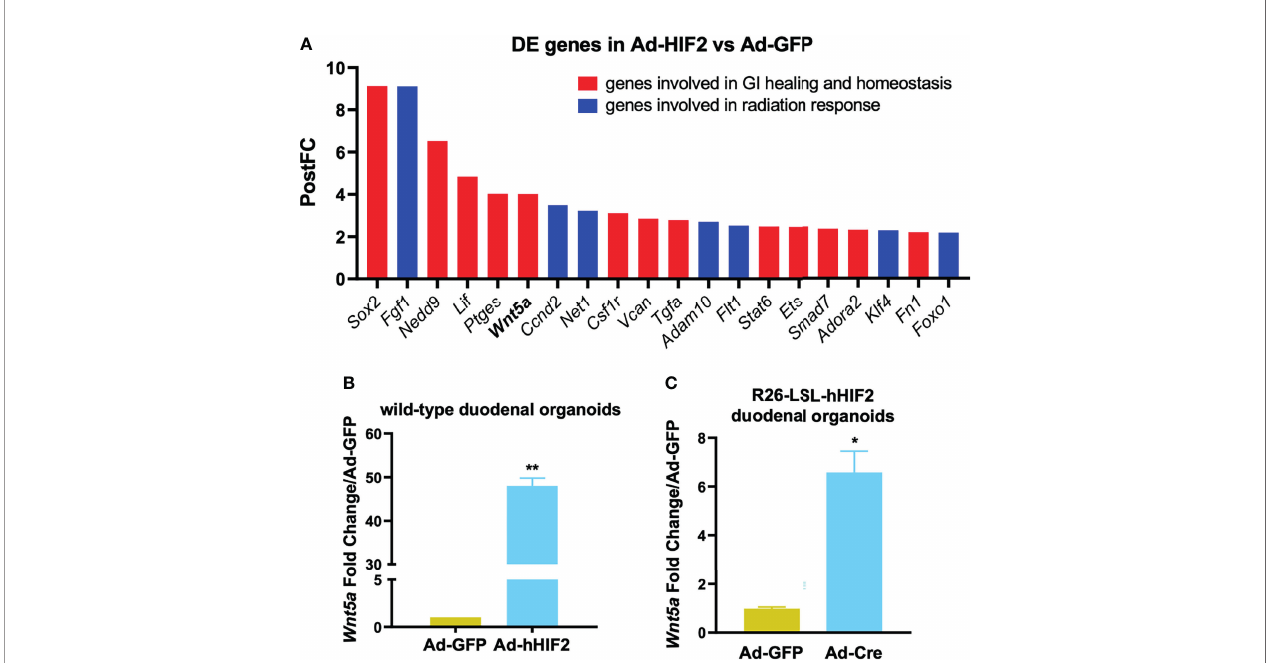
FIGURE 3 | Candidate approach identi fi es Wnt5a as direct HIF2 target. (A) Post-Fold Change (PostFC) of 20 differentially expressed (DE) genes identi fi ed from the RNA sequencing analysis. (B) qRT-PCR validation of HIF2-induced Wnt5a upregulation in wild-type duodenal organoids infected with Ad-GFP or Ad-hHIF2. Data represents 3 biological replicates (3 technical replicates/mouse). (C) qRT-PCR showing HIF2-induced upregulation of Wnt5a in LSL-hHIF2 duodenal organoids infected with Ad-GFP or Ad- Cre. Data represents 3 biological replicates (3 technical replicates/mouse). All error bars represent mean ± SEM. *P < 0.05, **P < 0.01, by Student ’ s t